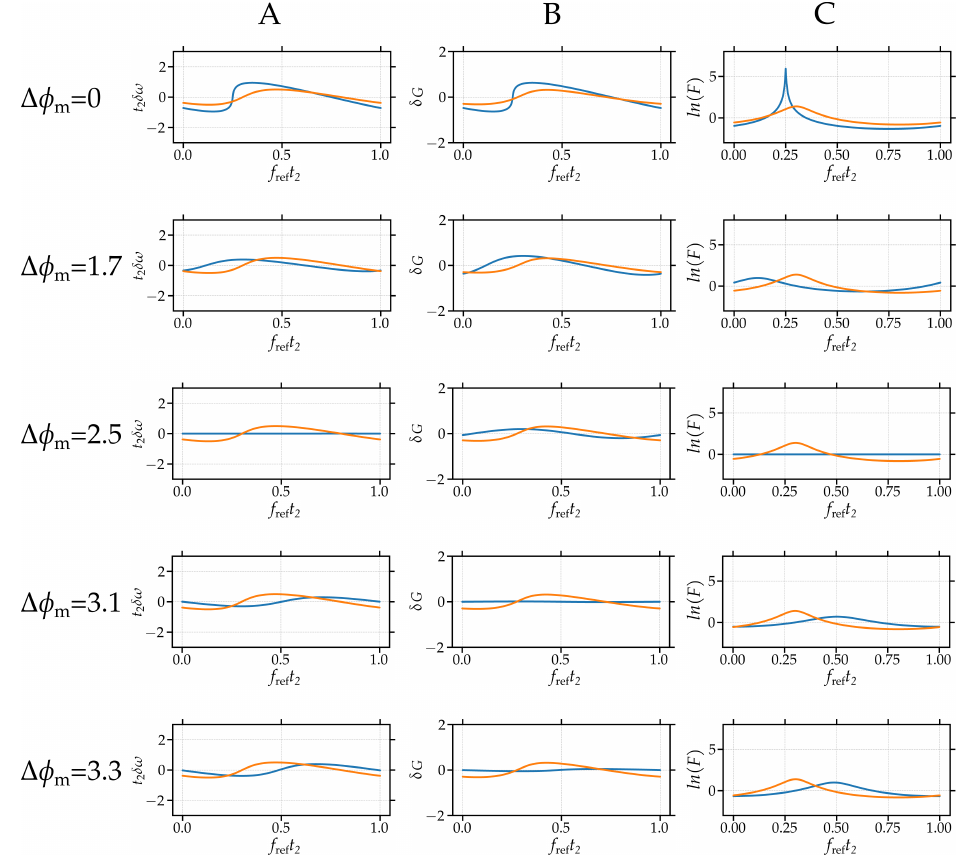
Figure 2. Numerical solutions for C = 0.5 under conditions (8) and (11) for different ∆ φ m . Double- feedback case shown in blue, single feedback case shown in orange. Column ( A ) shows the lasing frequency shift results. Column ( B ) shows the threshold gain shift. Column ( C ) shows the intrinsic linewidth